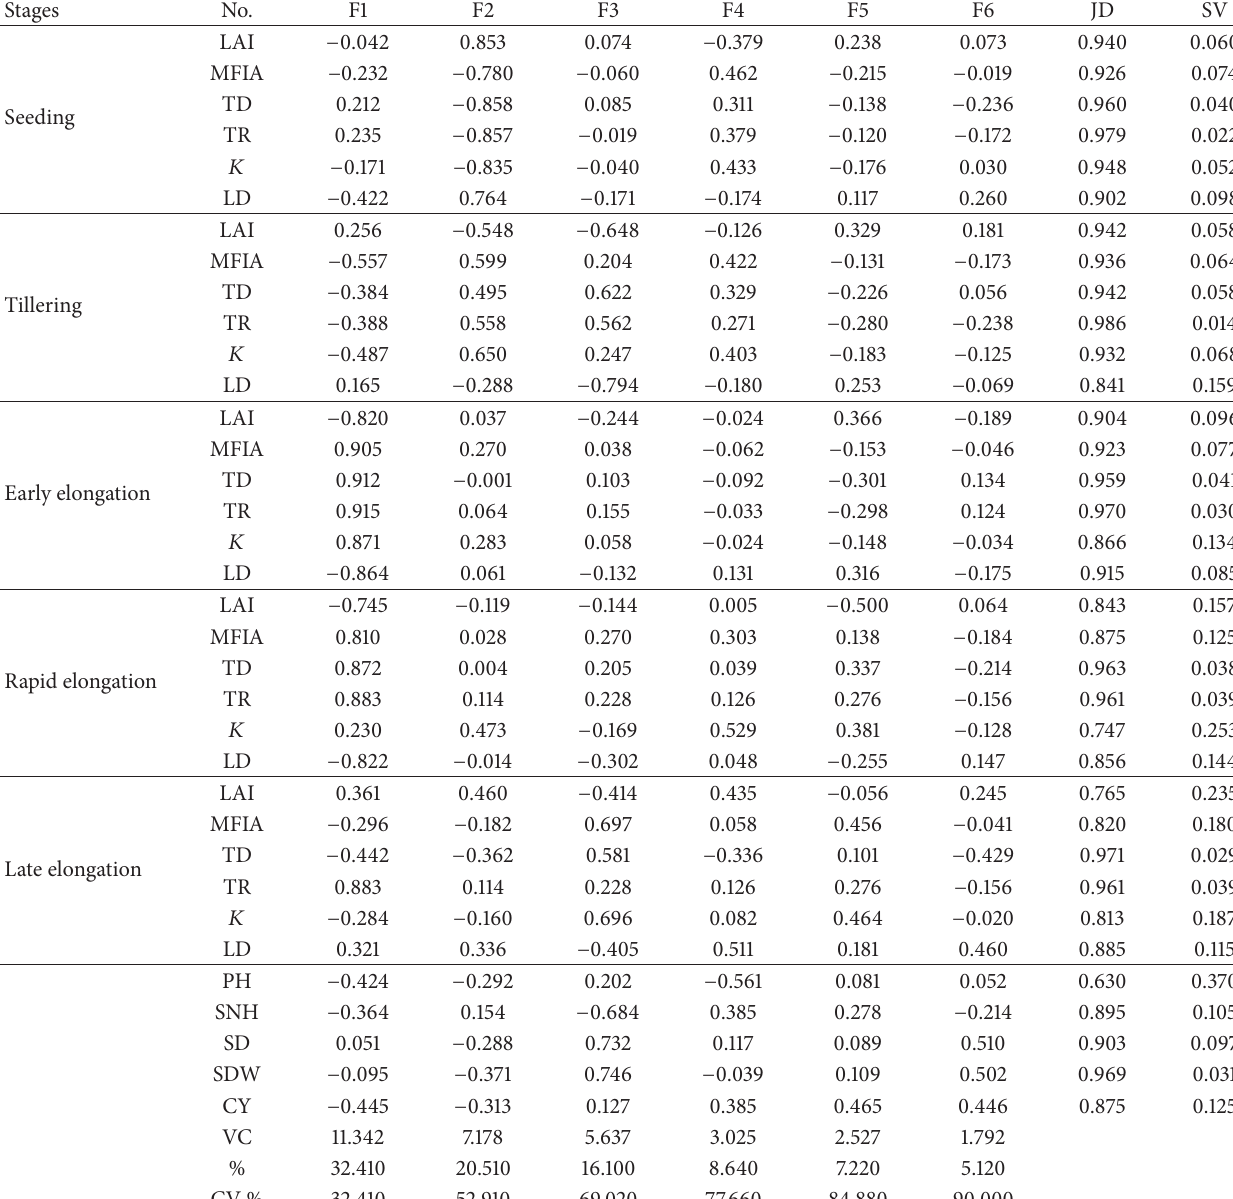
Table 7: Loading matrix of characters initial